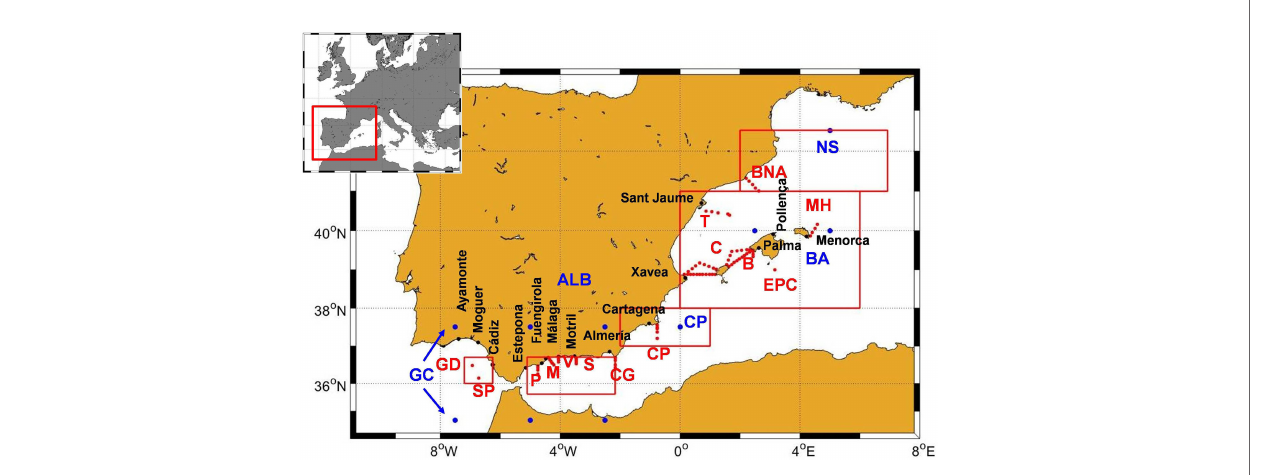
FIGURE 1 | Map of the area of study. Red dots and labels show the position of the STOCA and RADMED oceanographic stations. Black dots and labels are the position of the coastal meteorological stations from the Spanish meteorological agency (AEMET). Red rectangles are the regions where Argo MLD, Chlorophyll concentration, and SST data were averaged for obtaining monthly time series. Blue dots are the NCEP/NCAR grid points where reanalysis data were collected and averaged for obtaining monthly time series over the same regions used for MLD, Chl and SST